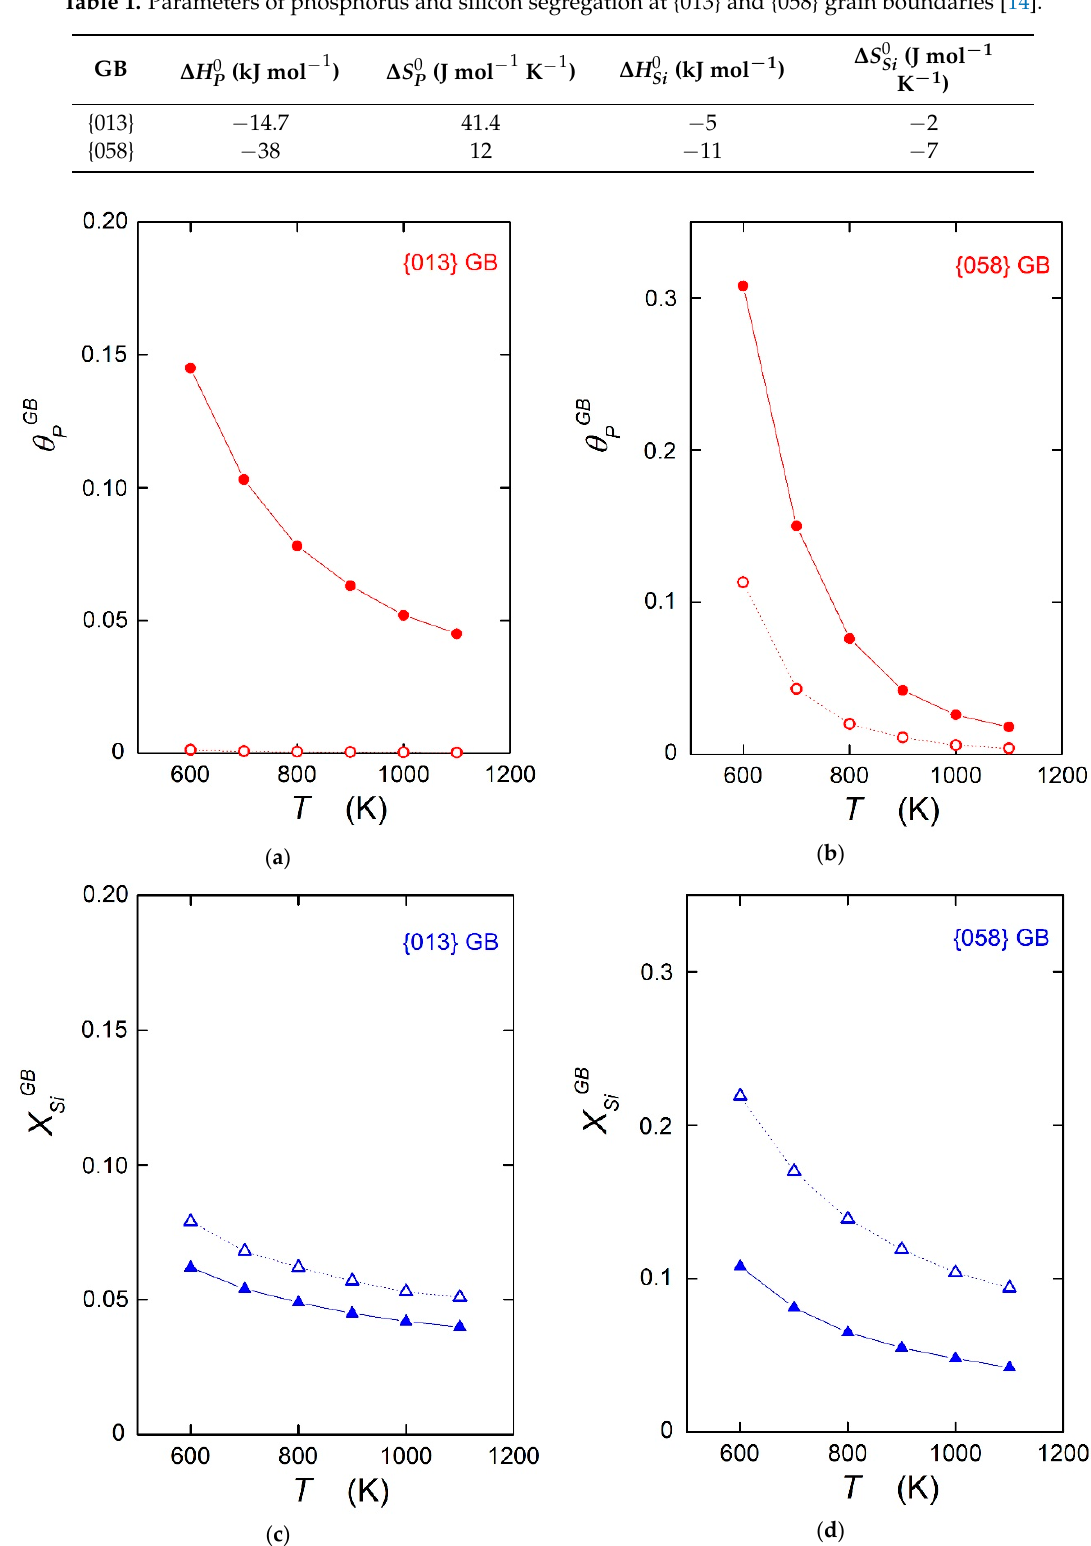
Table 1. Parameters of phosphorus and silicon segregation at {013} and {058} grain boundaries [14].